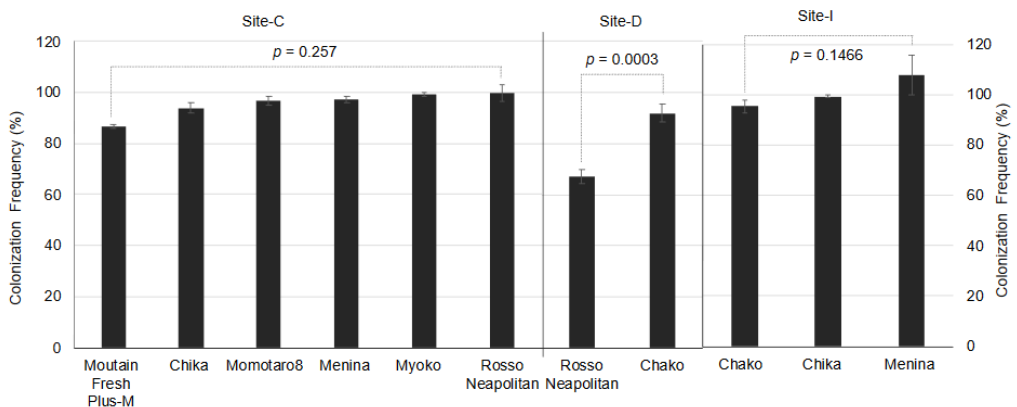
Figure 1. Colonization frequency (CF) of fungal endophyte of the stem of nature farming tomato ( Solanum lycopersicum ) at three experimental sites in the INFRC. The CF refers to the mean number of tissues colonized in a cultivar and expressed as percentage (%) of tissue planted in PDA plate. The error bar indicates the standard error (SE) of the mean. The p -values were obtained from Kruskal–Wallis (Site-C and I) or ANOVA (Site-D) to indicate significant di ff erences.